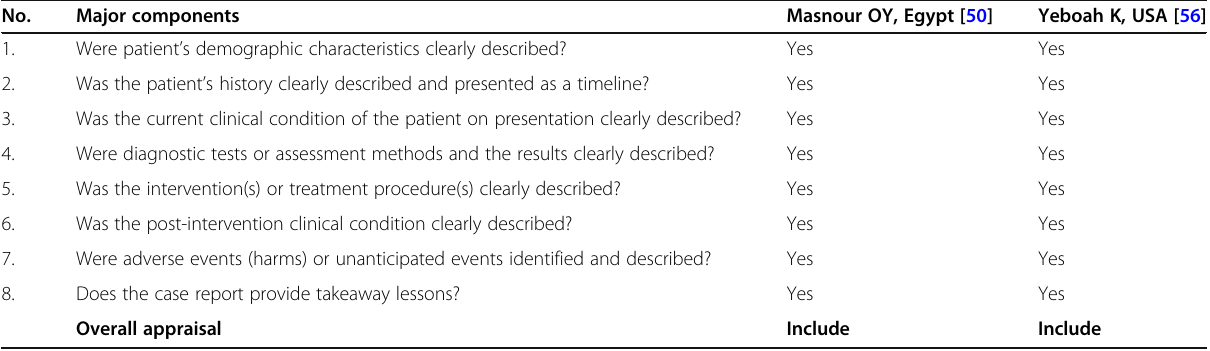
Table 4 JBI Critical Appraisal Checklist for case report No. Major